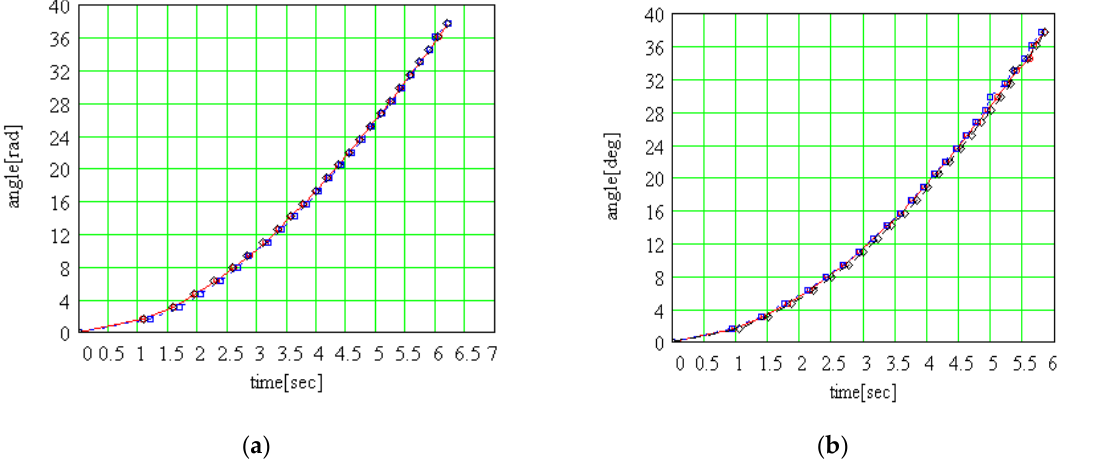
Figure 20. Experimental rolling angle: ( a ) symmetrical rotor; ( b ) asymmetrical rotor.